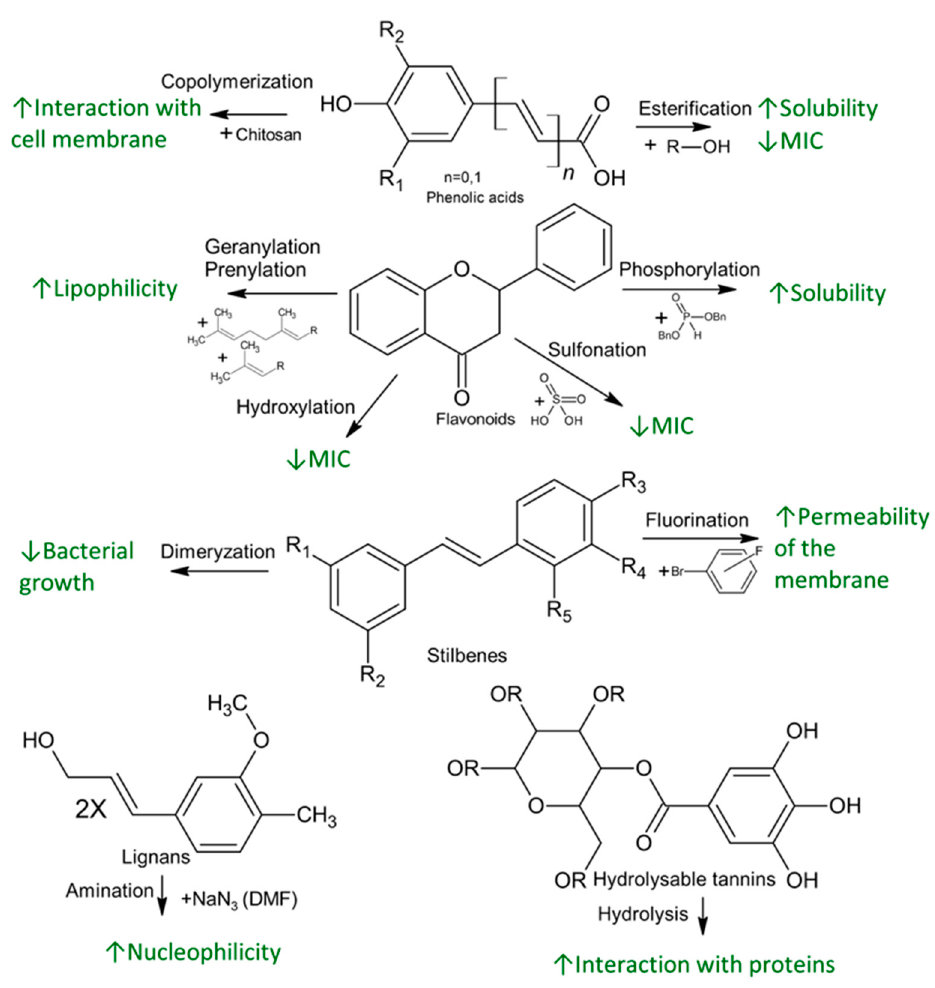
Figure 2. Possible routes for functionalization and increase of activity of phenolic compounds.